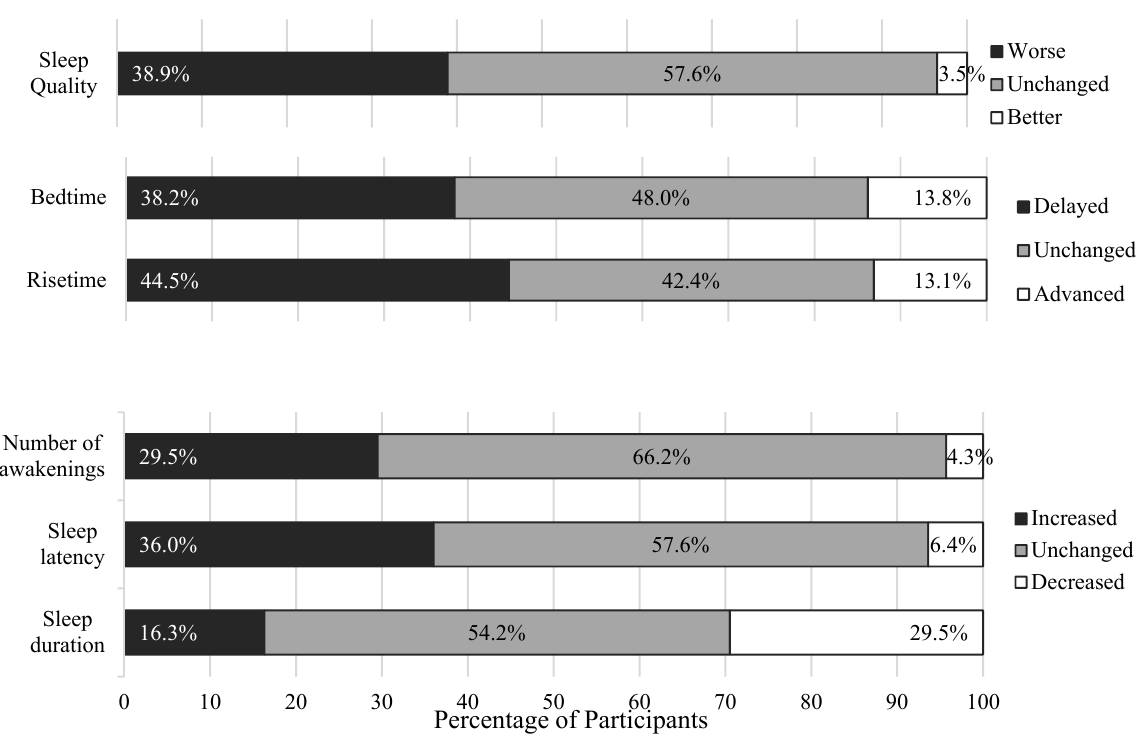
Figure 1. The retrospective changes in sleep pattern during the COVID-19 second wave lockdown period relative to the pre-pandemic time.